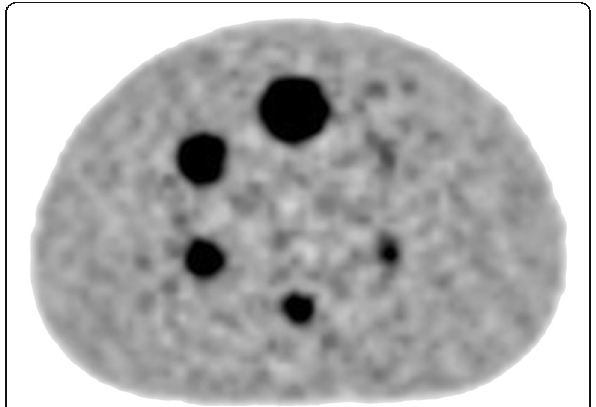
Fig. 1 Image taken from a central slice of the NEMA